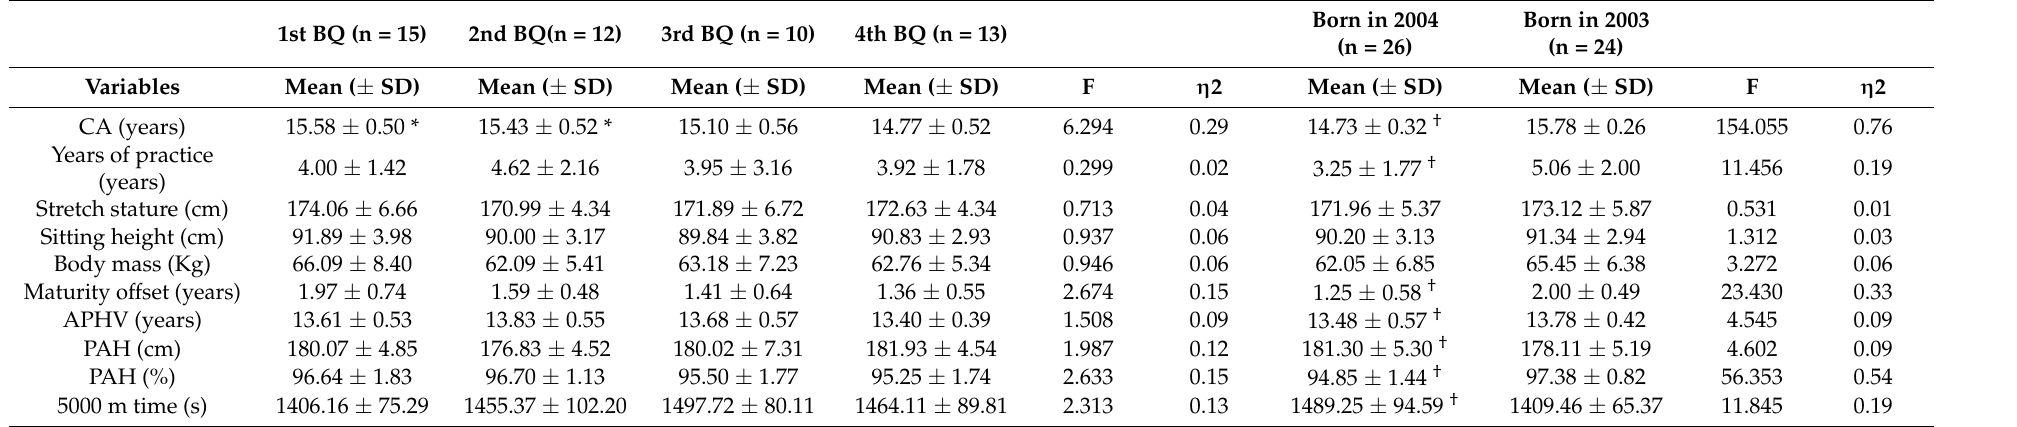
Table 4. Characteristics (means and standard deviations) of U16 kayakers by birth quarter (n = 50), year of birth (2004, n = 26 and 2003, n = 24) and results of ANOVA, and estimated effect sizes ( η 2